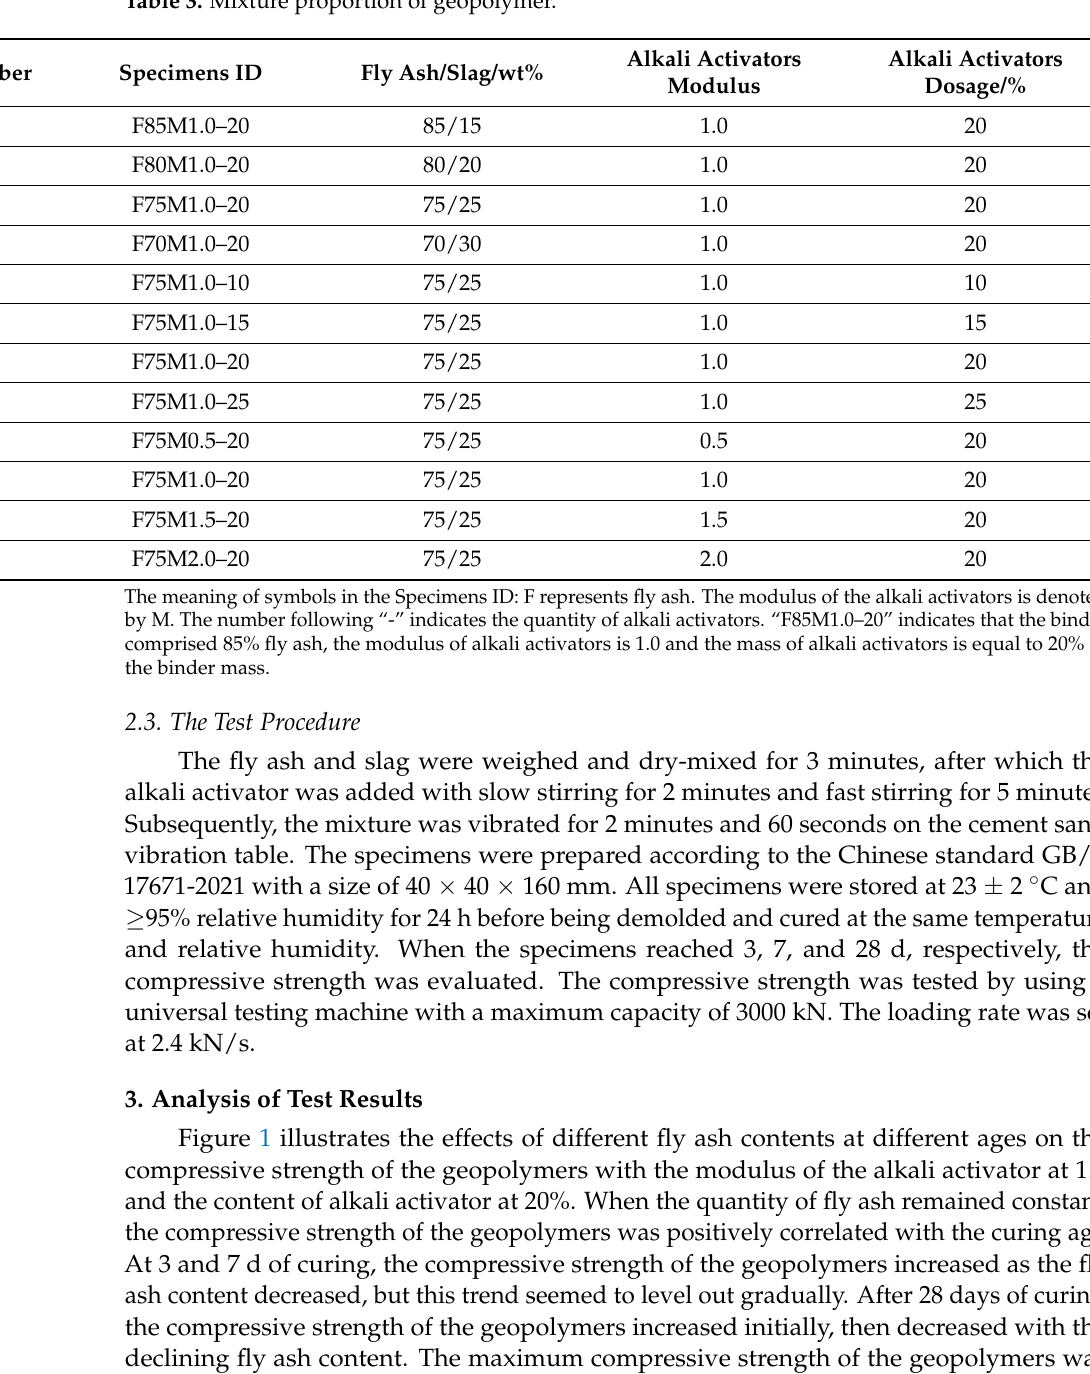
Table 3. Mixture proportion of